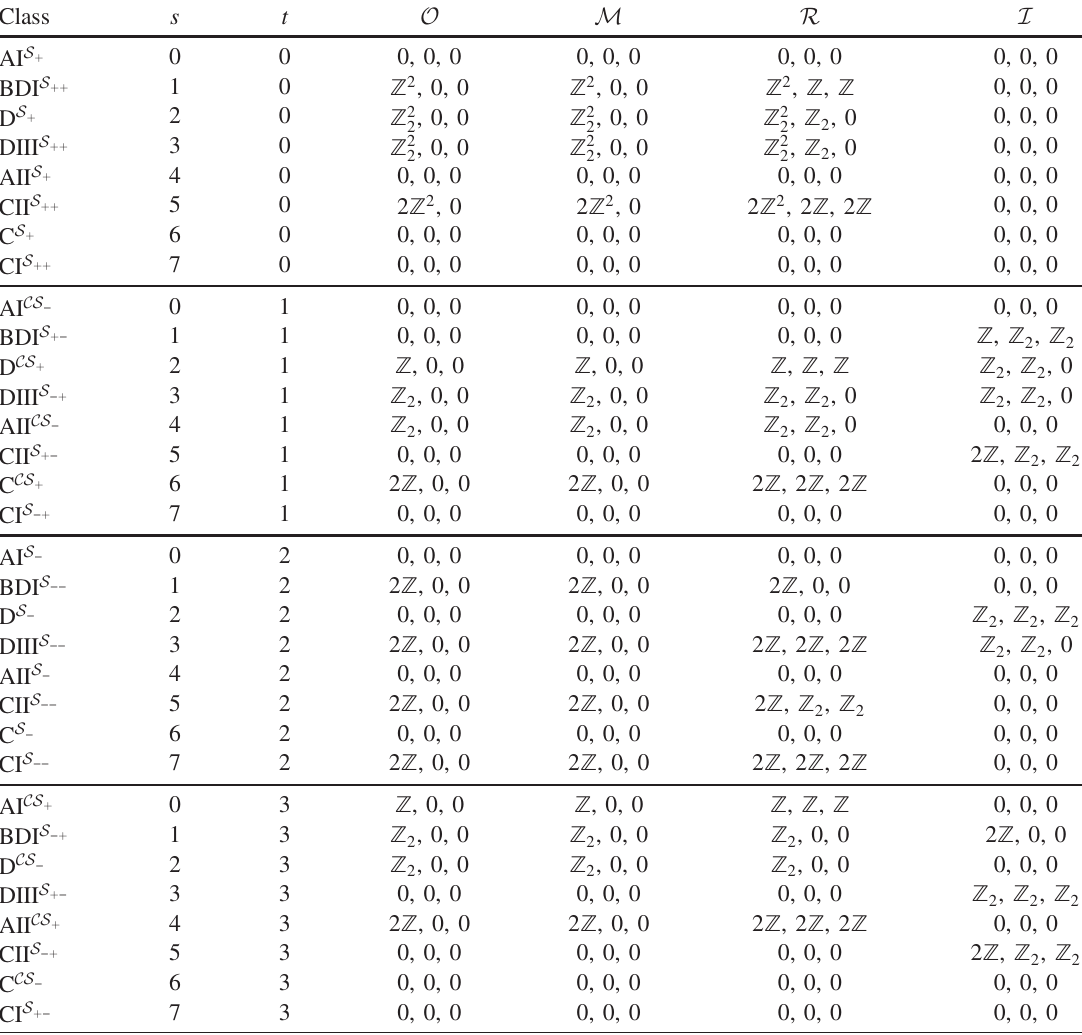
TABLE XII. Boundary classification of third-order phases in three-dimensional systems with an order-two symmetry (antisymmetry) for real tenfold-way classes. The symbols O , M , R , and I refer to a local